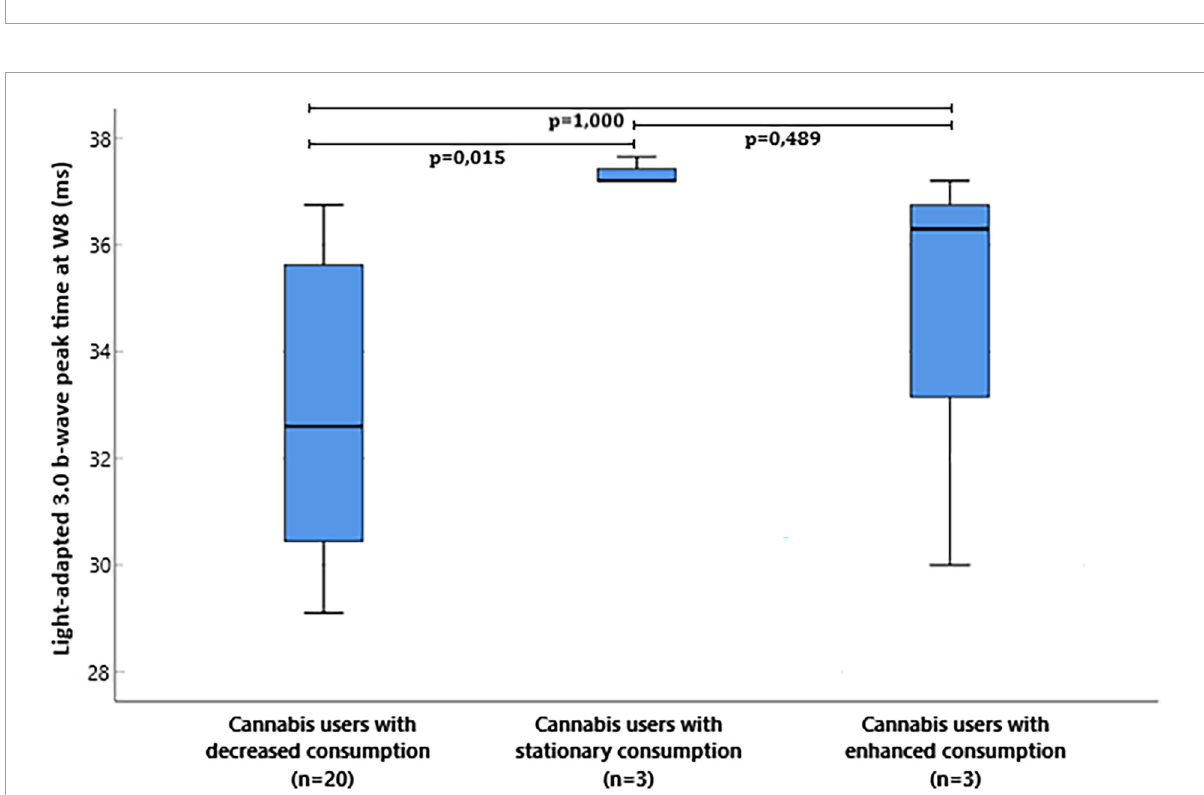
FIGURE2 Box plot of flash electroretinogram (ERG) light-adapted 3.0 b-wave peak time milliseconds (ms) at W8 in cannabis users divided in groups depending on the evolution of consumption between W0 and